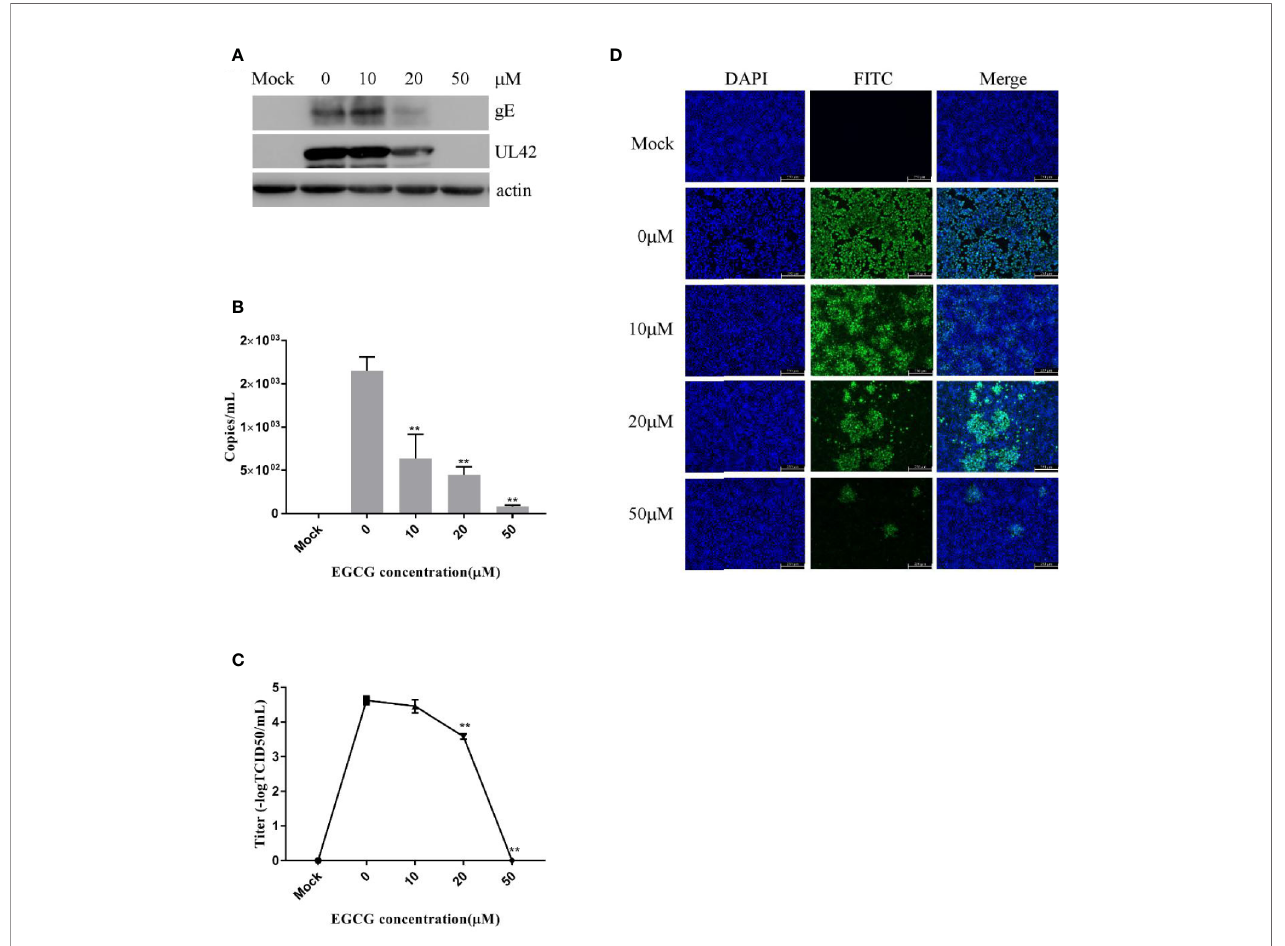
FIGURE 4 | ( – )-Epigallocatechin-3-gallate (EGCG) prevents pseudorabies virus (PRV) adsorption in PK15 B6 cells. PK15 B6 cells were pre-treated with 10, 20, or 50 m M EGCG for 1 h, then infected with PRV XJ5 (MOI=0.1) at 4°C for 1 h in the presence of 10, 20, or 50 m M EGCG before removal of the EGCG medium and culture in EGCG-free Dulbecco ’ s modi fi ed Eagle medium (DMEM). (A) At 24 hpi, PRV gE, UL42 and b -actin protein expression was analyzed by Western blot. (B) Viral DNA was quanti fi ed by qRT-PCR, (C) 50% tissue culture infective dose (TCID 50 ) was used to detect viral titer and (D) immuno fl uorescent assay (IFA) for internalized virus was performed. **p <